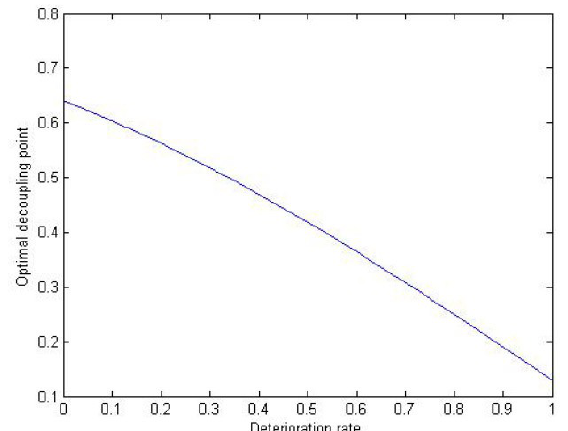
Figure 3. The relationships between the optimal decoupling point and deterioration rate